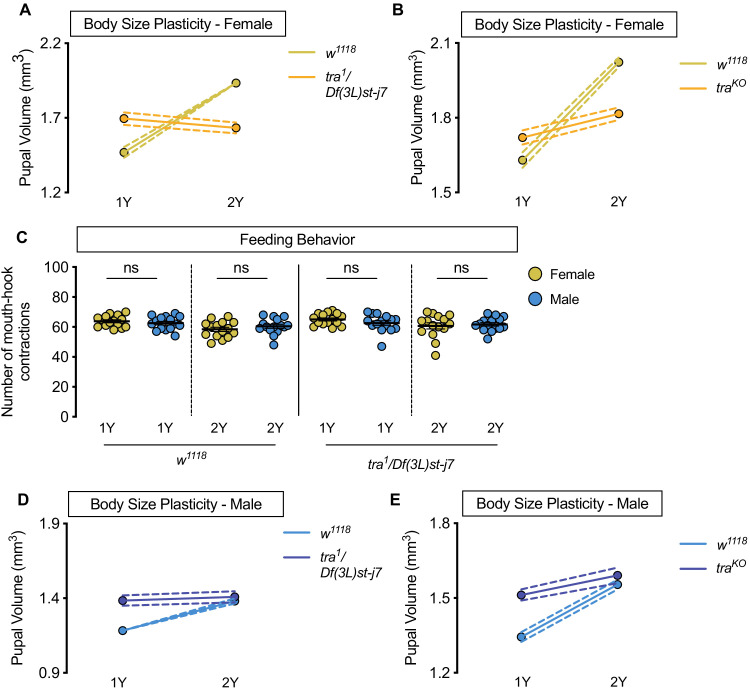
Increased nutrient-dependent body size plasticity in females requires transformer.(A) Pupal volume was significantly higher in w1118 females reared on a protein-rich diet (2Y) compared with w1118 females cultured on a diet containing half the protein concentration (1Y) (p<0.0001; two-way ANOVA followed by Tukey HSD test); however, this nutrient-dependent increase in pupal volume was not observed in transformer (tra) mutant females (tra1/Df(3L)st-j7) (p=0.1036; two-way ANOVA followed by Tukey HSD test). The magnitude of the nutrient-dependent increase in pupal volume was lower in tra1/Df(3L)st-j7 females (genotype:diet interaction p<0.0001). n = 39–69 pupae. (B) Pupal volume was significantly higher in w1118 females and tra mutant females (traKO) reared on 2Y compared with w1118 females and traKO females cultured on 1Y (p<0.0001, for both comparisons; two-way ANOVA followed by Tukey HSD test); however, the magnitude of the nutrient-dependent increase in pupal volume was lower in traKO females (genotype:diet interaction p<0.0001). n = 71–81 pupae. (C) There was no significant difference in mouth-hook contractions between w1118 control male and female larvae raised on 1Y (p=0.4103; Student’s t test), or 2Y (p=0.2961; Student’s t test). There was no significant difference in mouth hook contractions between tra mutant (tra1/Df(3L)st-j7) male and female larvae raised in 1Y (p=0.1961; Student’s t test), or 2Y (p=0.6732; Student’s t test). n = 15 biological replicates. (D) Pupal volume was significantly higher in w1118 males (p<0.0001; two-way ANOVA followed by Tukey HSD test), but not in tra1/Df(3L)st-j7 mutant males reared on 2Y compared with genotype-matched males cultured on 1Y (p=0.6643; two-way ANOVA followed by Tukey HSD test). n = 37–65 pupae. (E) Pupal volume was significantly higher in w1118 males and tra mutant males (traKO) reared on 2Y compared with genotype-matched males cultured on 1Y (p<0.0001, for both comparisons; two-way ANOVA followed by Tukey HSD test). n = 44–80 pupae. For body size plasticity graphs, filled circles indicate mean pupal volume, and dashed lines indicate 95% confidence interval. ns indicates not significant; error bars indicate SEM.